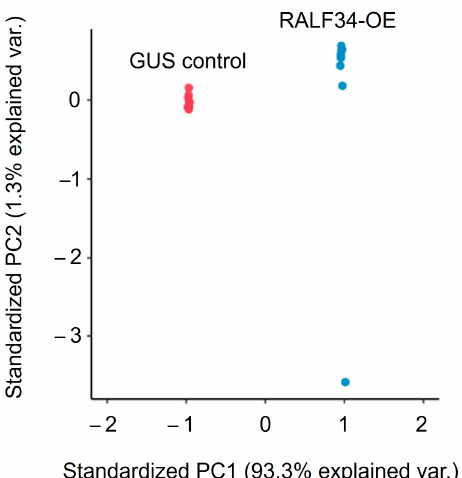
Figure 7. Principal component analysis with a score plot for transgenic Cucumis sativus roots containing either p35S::gusA (GUS controls) or p35S::CsRALF34 (RALF34-OE). Principal compo- nent 1 (PC1) showed the inter-group differences (93% of explained variability) associated with CsRALF34